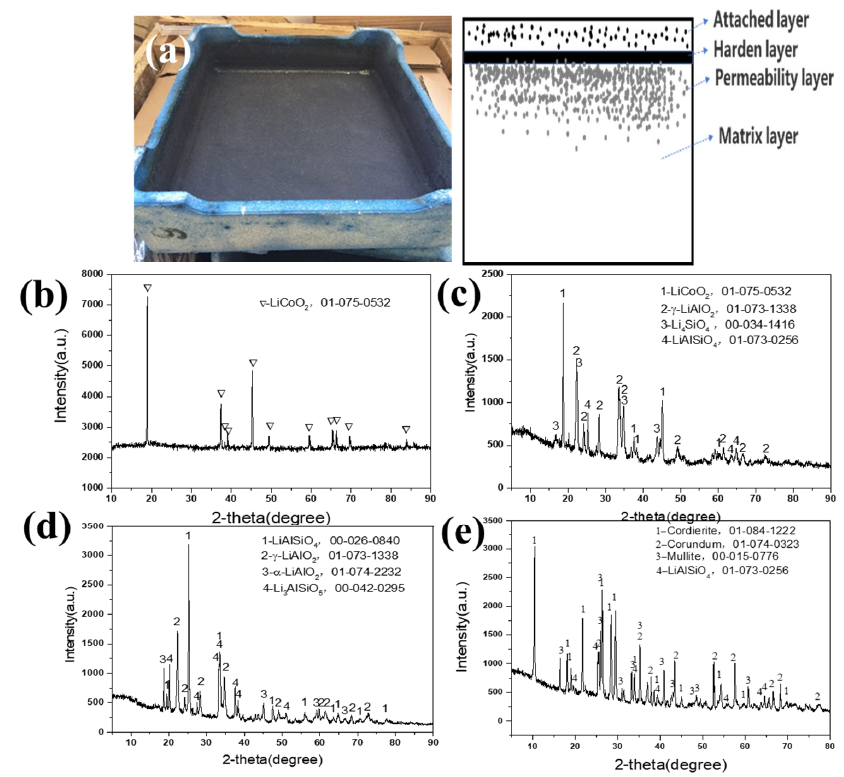
Figure 2. XRD patterns of different regions of waste saggar produced during the synthesis of LiCoO 2 cathode material. ( a ) Photo of real waste saggar and a section diagrammatic drawing; ( b ) XRD pat ‐ tern of the attached layer; ( c ) XRD pattern of the hardened layer; ( d ) XRD pattern of the permeability layer; ( e ) XRD pattern of the matrix